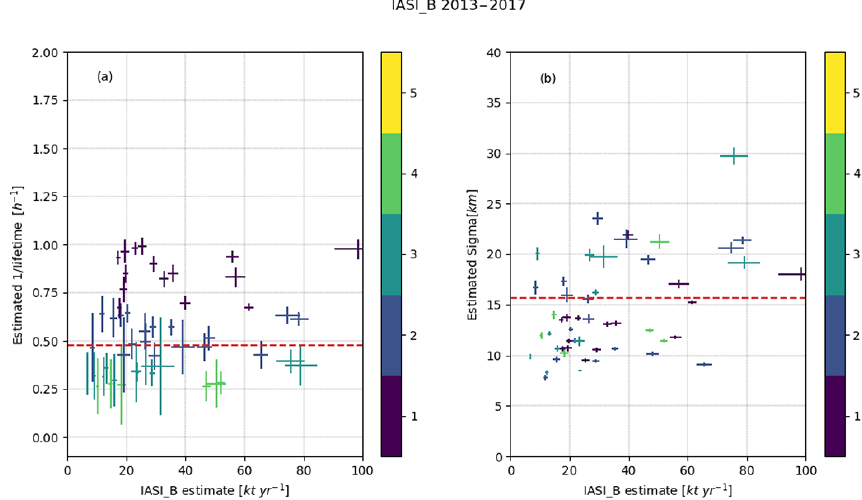
Figure C2. All successful fits for the 5-year (2013–2017) IASI-B dataset with a correlation > 0.5 and a SNR > 2. Panel (a) shows the fitted emissions vs. the λ parameter and (b) the fitted emissions vs. the fitted σ with the horizontal and vertical error bars showing the uncertainties of the fit. The color of the bars indicates the fitted lifetime rounded to the nearest integer. The horizontal striped red lines show the weighted average of the λ and σ